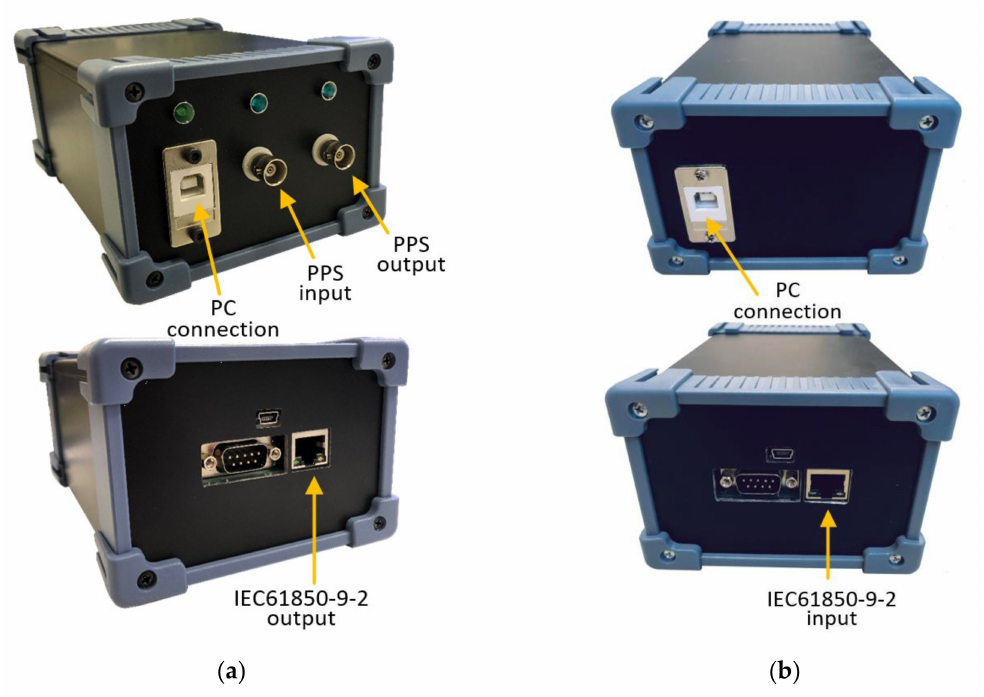
Figure 11. ( a ) Photo of the microcontroller-based SV generator box with additional port information. ( b ) Photo of the microcontroller-based SV receiver box with additional port